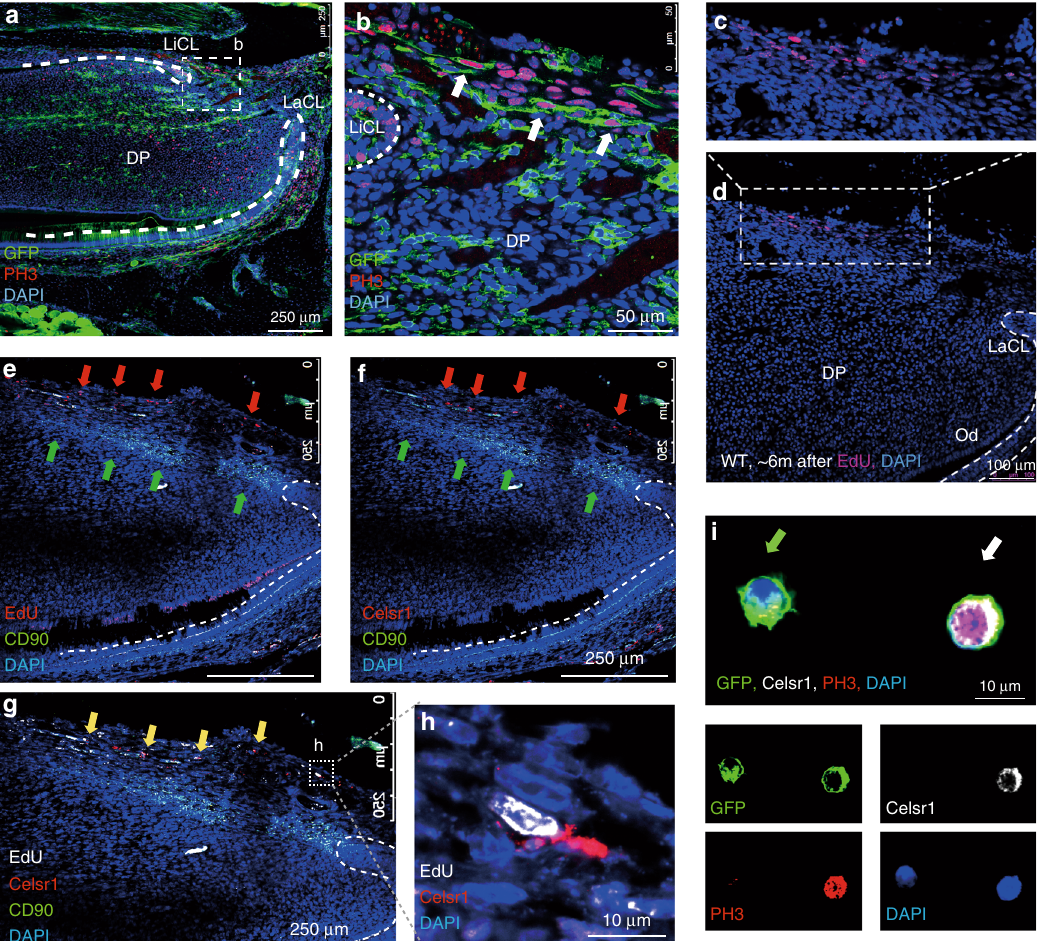
Fig. 6 Quiescent cells act as a reservoir and mobilize to form stem cells. a , b PH3 immuno-staining of sections of CD90/Thy1 cre; mTmG mice shows proliferating cells become detectable in the mesenchyme between the two aspects of the cervical loop after incisor clipping. c , d Detection of EdU incorporating cells that had been labeled during embryonic development from E2.5 to E17.5 and chased for over 6 months, showing a small population of EdU+ cells distributed in a line at then most proximal end of incisor mesenchyme. e Co-staining with CD90/Thy1 and EdU labeled quiescent cells shows CD90/Thy1 cells are located in the mesenchyme adjacent to the EdU labeled cells, red arrows are EdU + and green arrows are CD90/Thy1 + cells. f Co- staining with CD90/Thy1 and Celsr1 shows CD90/Thy1 cells occupy the same location adjacent to the Celsr1 expressing cells. g Triple staining with CD90/Thy1, Celsr1 and EdU shows CD90/Thy1 expressing cells are located adjacent to the EdU and Celsr1 + cells, yellow arrows and h enlarged region showing the co-localization of EdU+ ; Celsr1 + cells. i Immuno-staining of FACS sorted GFP + cells from clipped CD90/Thy1-cre;mTmG mouse incisors with Celsr1 and PH3 on cytospin slides, identi fi es GFP+ ;Celsr1 + ;PH3 + triple positive (white arrow,) and GFP + ;Celsr1 − ;PH3 − cells (green arrow). Bar 250 µ m in